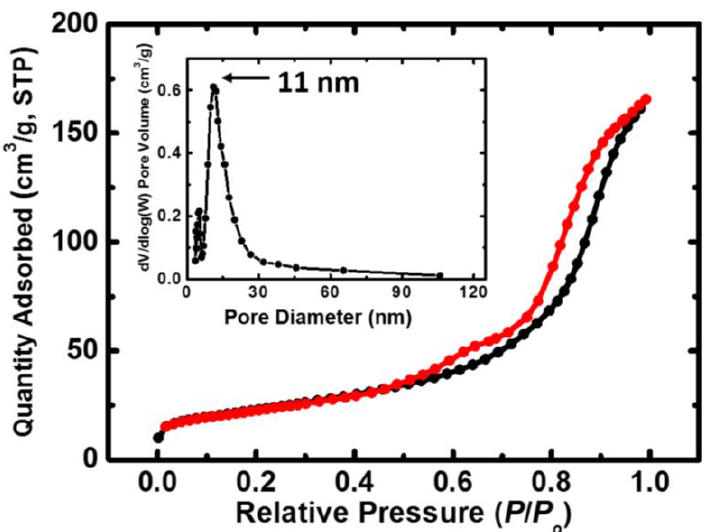
Figure 4. N 2 -sorption diagram for the N-TiO 2 nanoparticles. The black line represents adsorption and the red line represents desorption. The inset shows the pore size distribution as determined by the BJH method. Table 1. BET analysis and properties of N-TiO 2 powder.